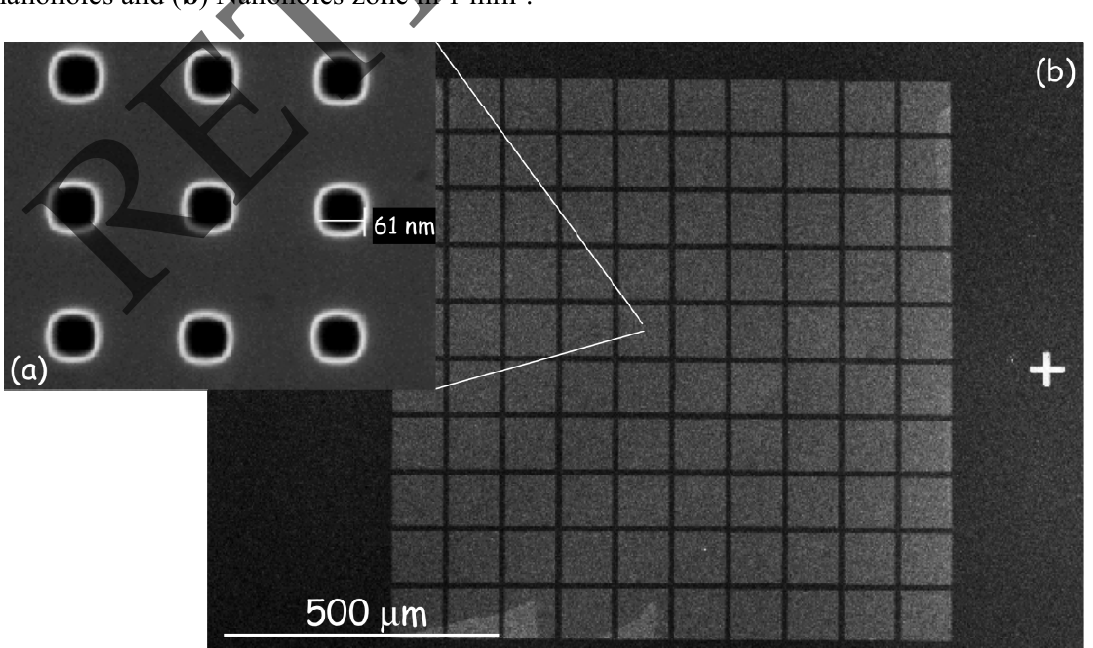
Figure 1. SEM images of the silicon master mold: ( a ) Zoom of a 100 × 100 μ m 2 zone of nanoholes and ( b ) Nanoholes zone in 1 mm 2